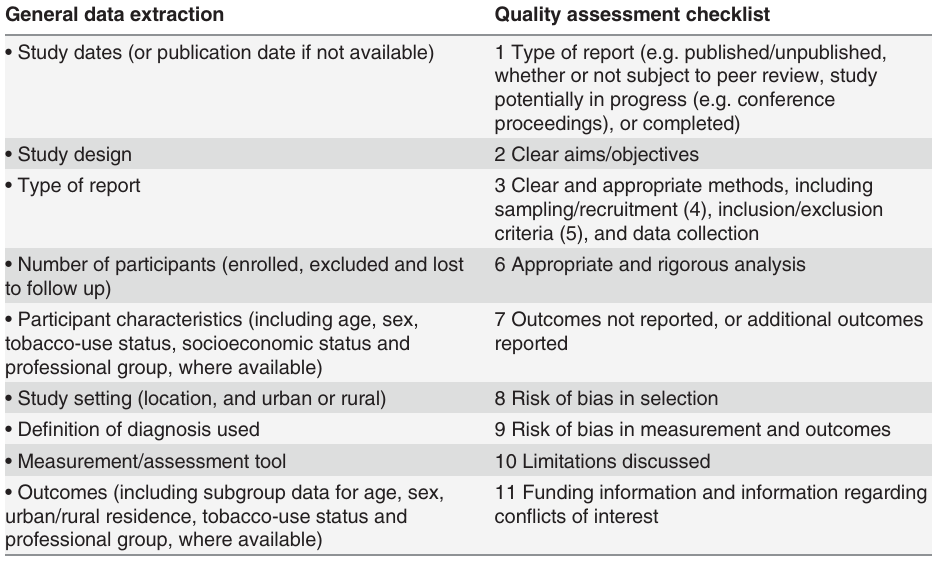
Table 2. Data extraction and quality assessment checklists. General data